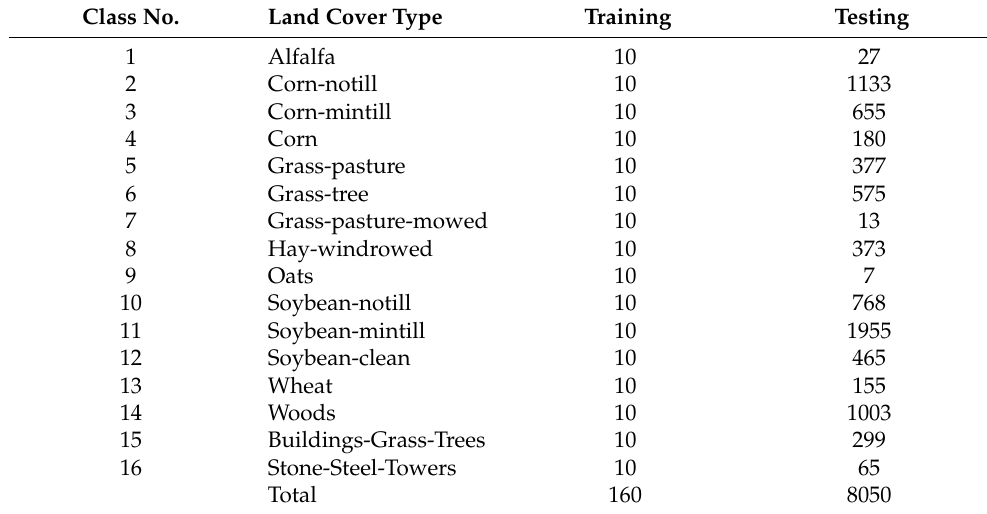
Table 1. The number of training, testing samples in the Indian Pines dataset. Class No.